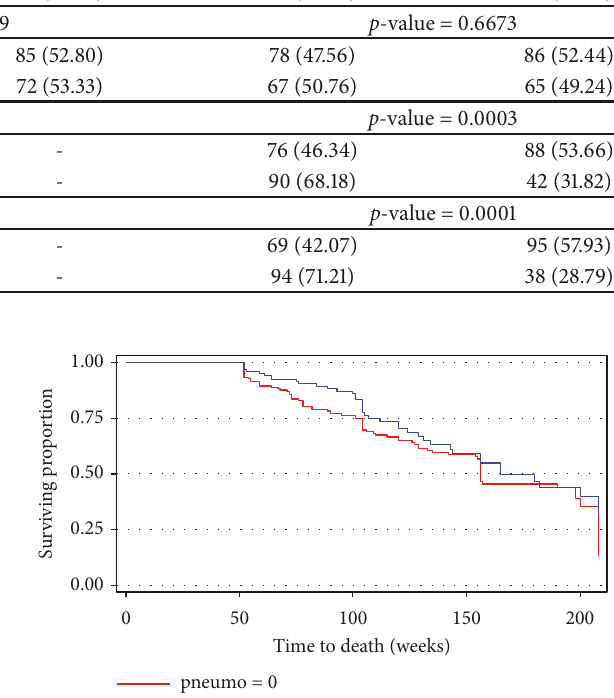
event of interest (death) relative to 50% at 156 weeks (shorter time) for children with